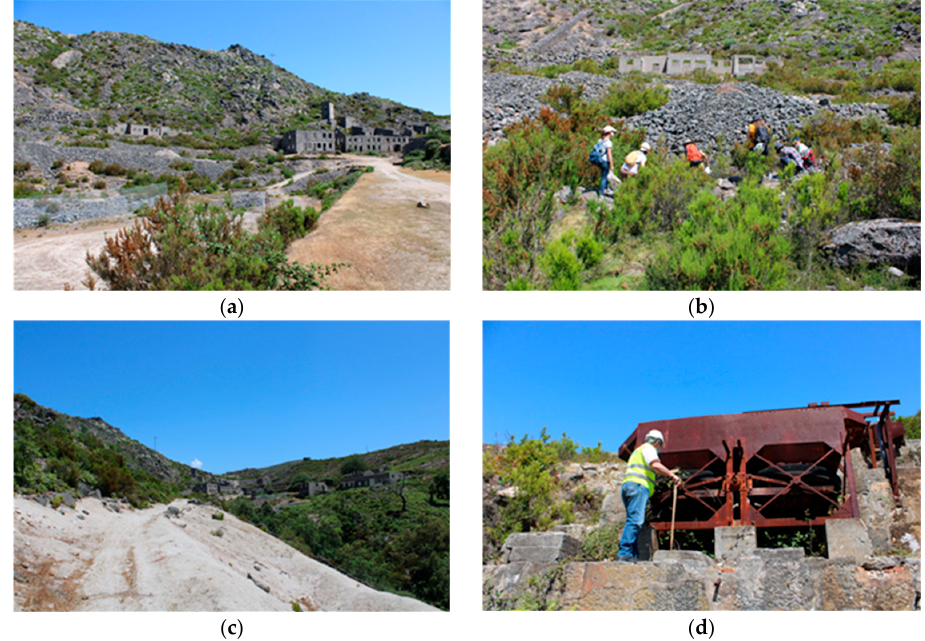
Figure 5. ( a ) Overview of the old Regoufe mining infrastructure; ( b , c ) nowadays, mining waste tail- ings; ( d ) remaining washing plant. tailings; ( d ) remaining washing